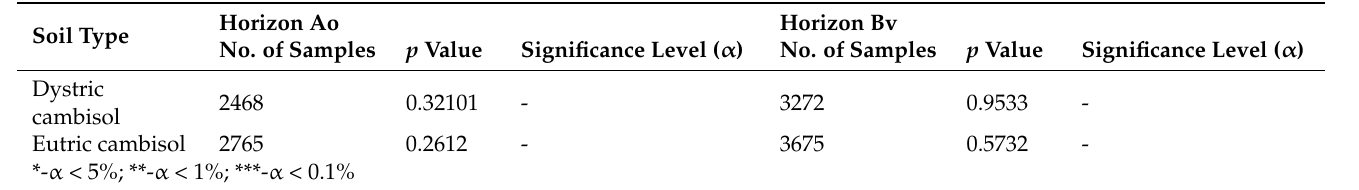
Table 2. Testing the significance among soil organic matter content of 8 different slope aspect categories for soil types as well as for the genetic horizon